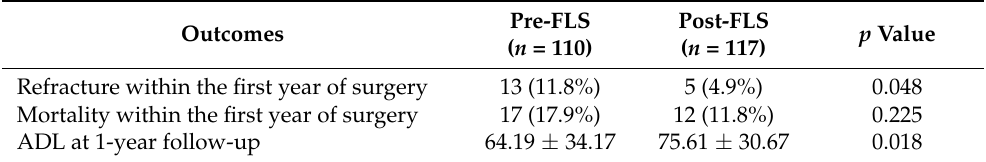
Table 4. Comparison of 1-year outcomes between the pre-FLS and post-FLS groups.